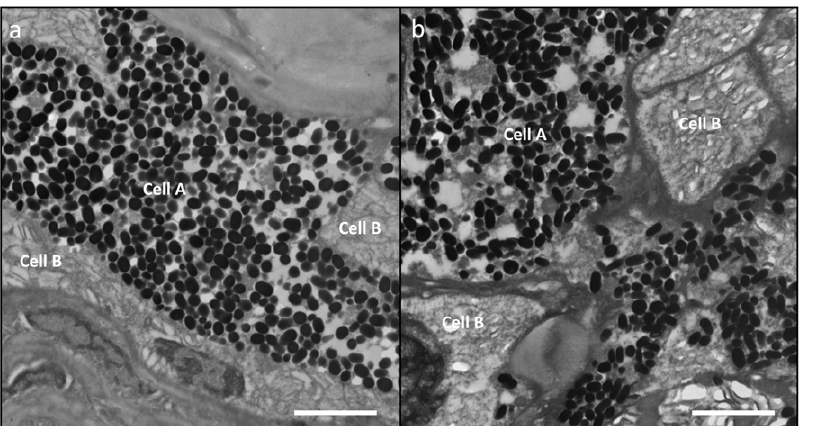
Figure 5. Transmission Electron Micrographs of different samples of P.leopardus exhibiting; (a) healthy tissue showing the two cell types (A & B) associated in the dermis along the collagenous basal membrane (CBM). Cell A shows localisation of melanosomes and Cell B shows absence of melanosomes in the same area. (b) Lesion showing disorganisation of pleomorphic cells (A & B) with an increase in number and spread of melanosomes. This lesion is an example of a P. leopardus suffering from stage II melanoma, where the melanosomes are restricted to the dermis. Scale bars=10 m m.